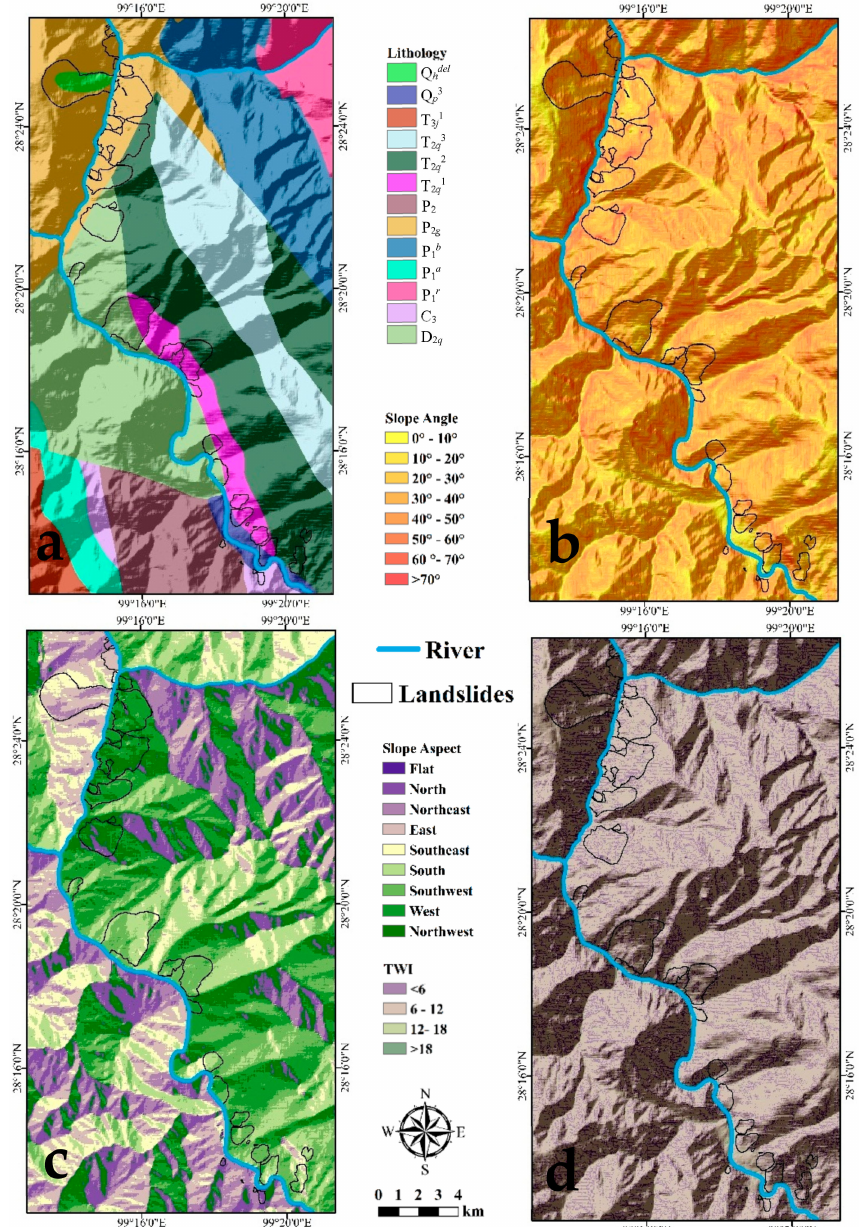
Figure 4. Influencing factors maps of the study area: ( a ) lithology; ( b ) slope angle; ( c ) slope aspect; and ( d ) topographic wetness index